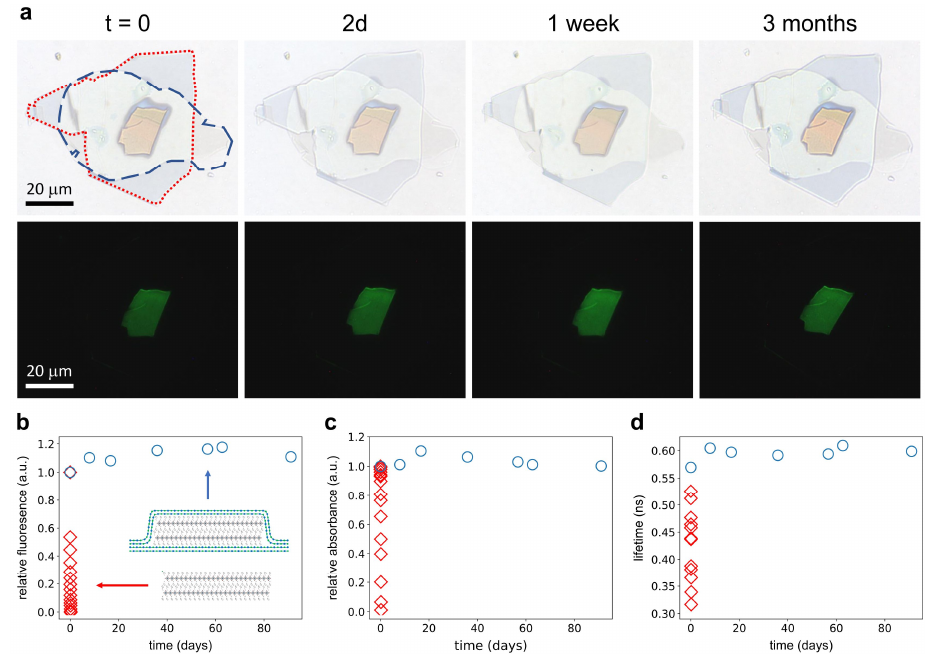
Figure 3. Spectral properties of a PEA 2 PbI 4 2D perovskite flake, which was encapsulated between two hexagonal boron nitride (hBN) layers; ( a ) Transmittance (top) and fluorescence (bottom) micrographs of the encapsulated perovskite flake showing no sign of degradation after exposure to ambient conditions for over three months. In the top left micrograph, we highlight the edges of the bottom (blue dashed) and top (red dotted) hBN flake; ( b ) Total fluorescence intensity of an encapsulated (circles) and un-encapsulated (diamonds) perovskite flake for different times under ambient condition. The intensities were normalized to the measured value at t = 0; ( c ) Integrated absorbance (455–594 nm) of an encapsulated (circles) and un-encapsulated (diamonds) perovskite flake for di ff erent times under ambient condition. The intensities were normalized to the measured value at t = 0; ( d ) 1 / e lifetime of an encapsulated (circles) and un-encapsulated (diamonds) perovskite flake for di ff erent times under ambient